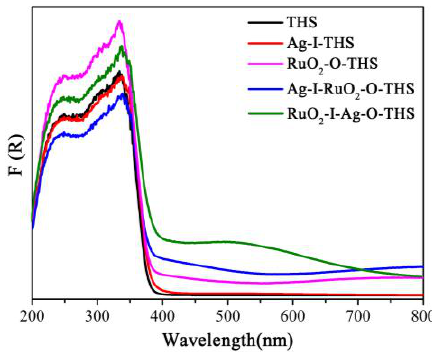
Figure 5. Ultraviolet-visible diffuse reflectance spectra (UV-Vis DRS) of THS loaded by the cocatalysts with different spatial dispersion.